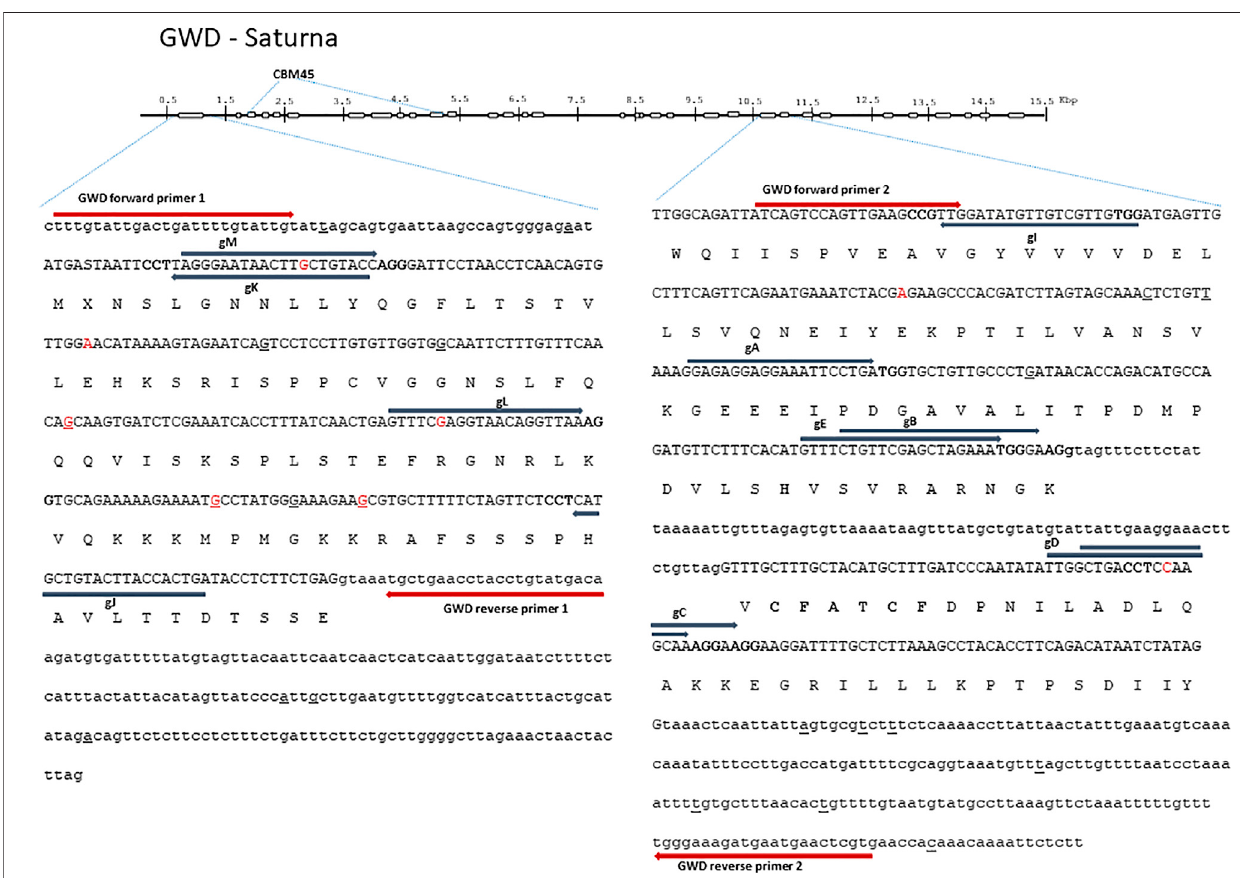
FIGURE 1 | Glucan Water Dikinase (GWD) 1 — structure and full allelic sequence of gRNA target regions. Overall gene structure with exons (boxes) and the area containingcarbohydrate-bindingmodule(CBM)depictedabove.Left:thenucleotidesequenceofexon1andintrons.Right:exon24and25includingintrons.Exonsare depictedincapitalletterswiththeaminoacidsequenceindicated.Smallnucleotidepolymorphisms(SNPs)fromcultivarsincludedintheSPUDdatabasearemarkedwith red, and SNPs found in Saturna are underlined. Grey arrows designate gRNAs (gA, gB, gC, gD, gE, gI, gJ, gK, gL, and gM) with PAM sites marked in bold. Red arrows designate diagnostic IDAA PCR primers. The “ CFATC ” region, containing cysteine ’ s hypothesized to be involved in inter or intra-di-sul fi de bond formation and thus in putative redox-state modulation of GWD activity is marked with bold. The active site histidine residue is also marked with bold.